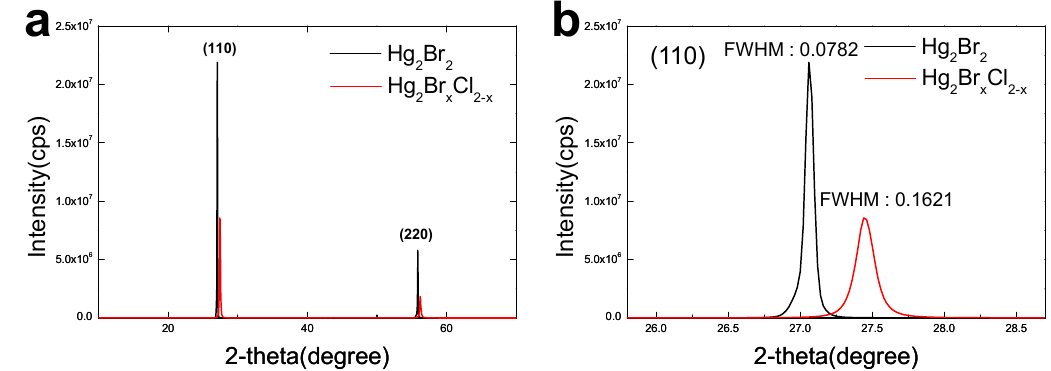
Figure 3. ( a ) Comparison of the X-ray diffraction (XRD) spectra of Hg 2 Br 2 and Hg 2 Br x Cl 2−x crystals. ( b ) Full width at half maximum (FWHM) of Hg 2 Br 2 and Hg 2 Br x Cl 2−x crystals at (110) peak.